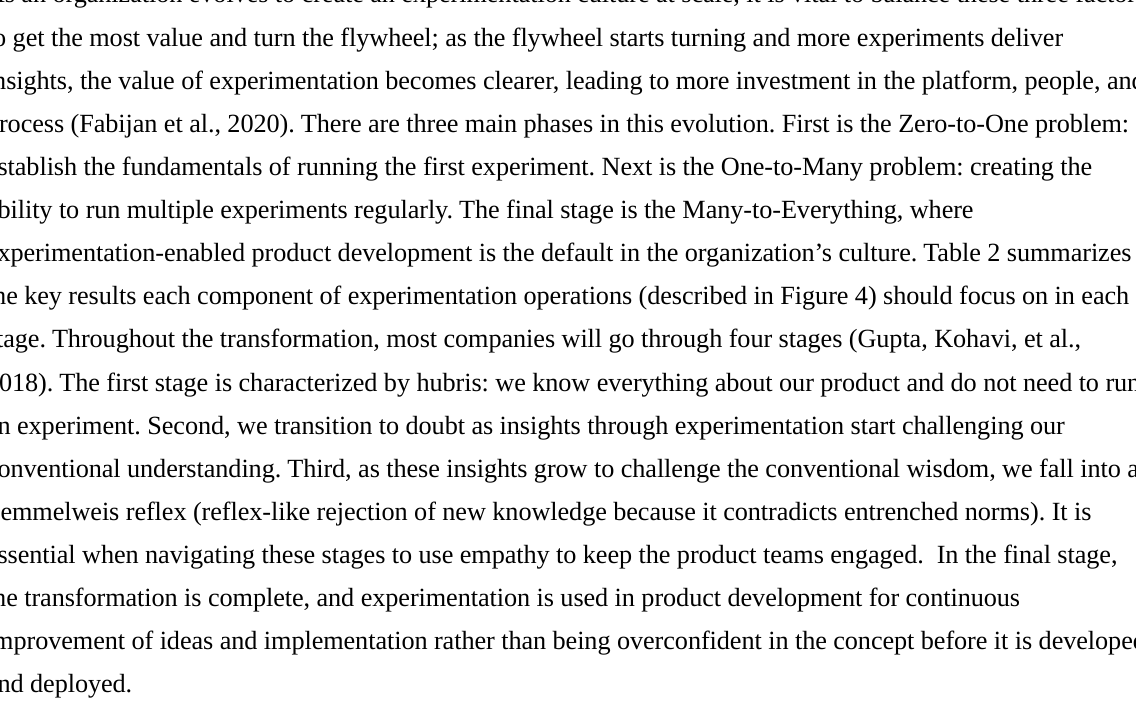
Table 2. Experimentation scaling guide.